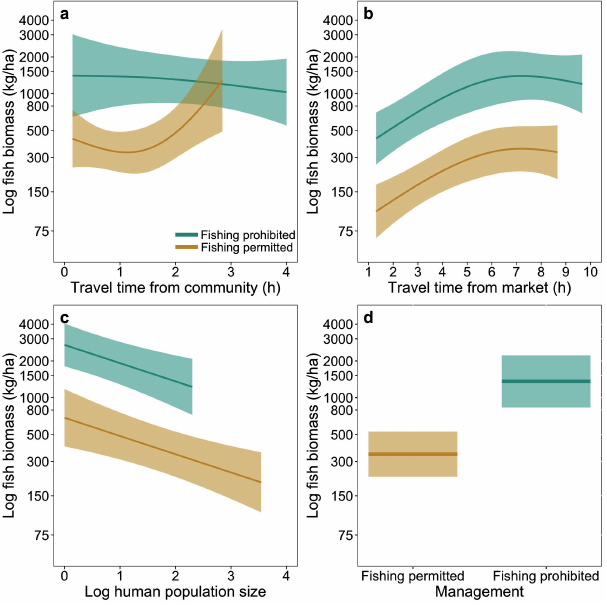
Fig. 2 . Partial effects of each socioeconomic covariate predicting log fish biomass in the model while considering the other predictor variables are held constant. Relationships between fish biomass and travel time from the nearest community (a), travel time from the nearest market (b), human population size (c), and management (d) for reefs where fishing is permitted (orange) or fishing is prohibited